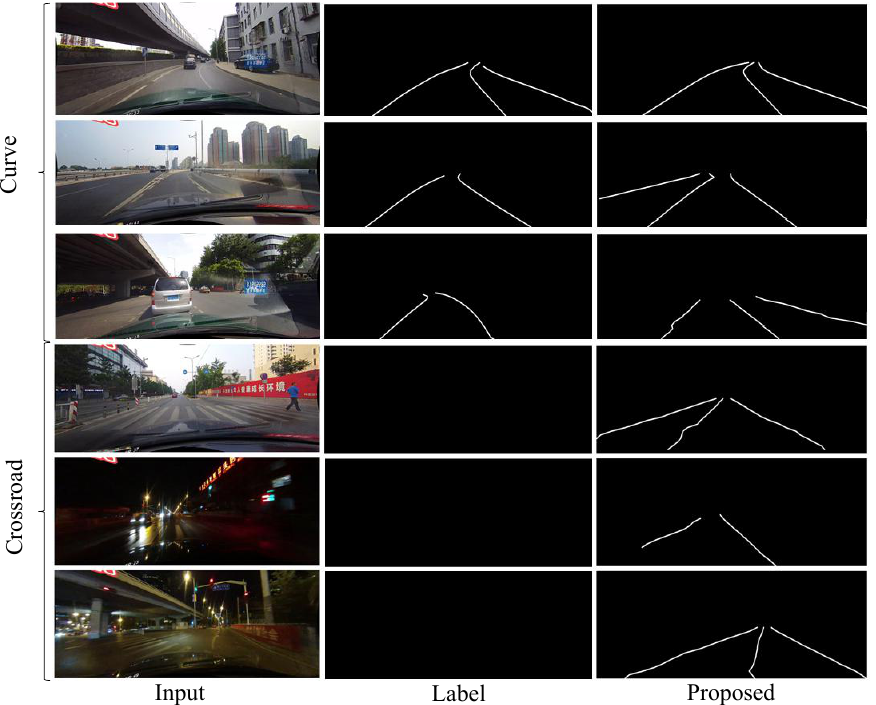
Figure 9. The lane detection results of the proposed model in the curved and crossroad scenes on CULane dataset. The first three rows are the results on partly curved scenes, and the last three rows show the results of our model in the crossroads. Note that the labels of the crossroad images are empty on the